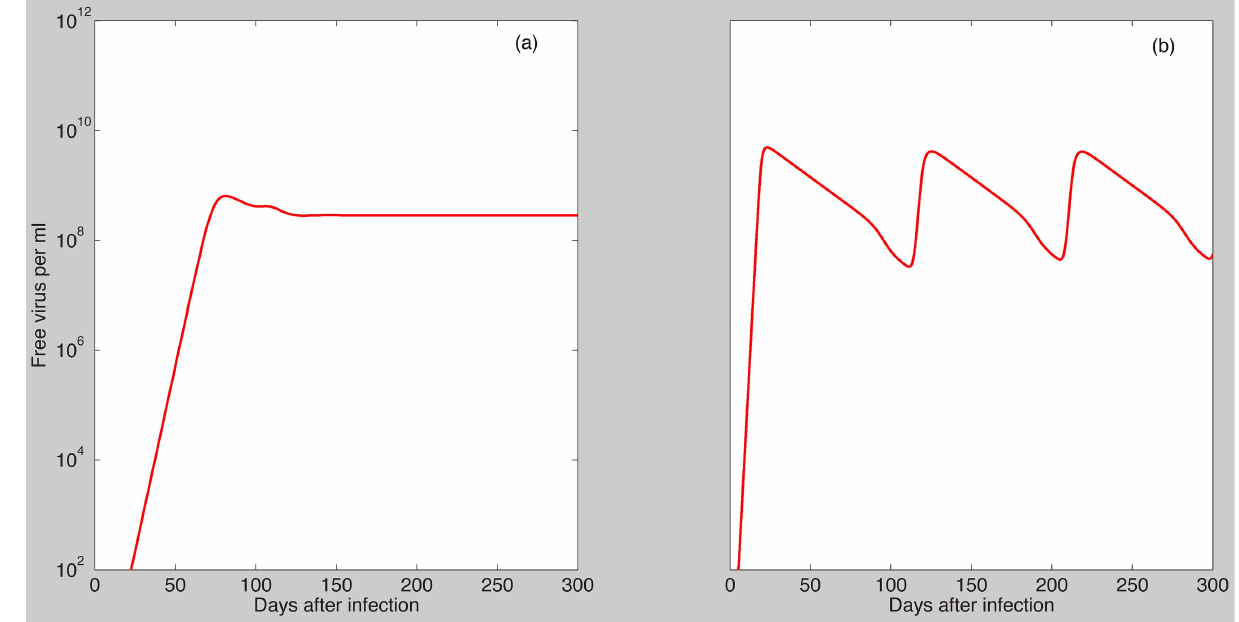
Figure 2. Dynamics of V as given by model (7) when the cleared infection condition (19) fails. Parameter values are as in Table 1 and A m ~ 4 | 10 12 molecules per ml, h ~ 10 3 , b ~ 6 : 1 | 10 { 10 ml per virus per day, d ~ 0 : 0494 d { 1 , r A ~ 0 : 358 d { 1 , p A ~ 1 : 16 | 10 { 5 molecules d { 1 , p ~ 42 : 5 per infected cell per day (panel a); p ~ 300 per infected cell per day (panel b).